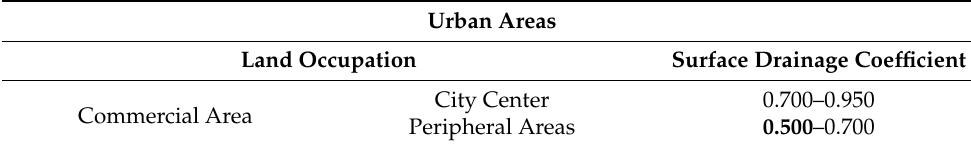
Table 4. Surface drainage coefficient adopted (Source: [30]).